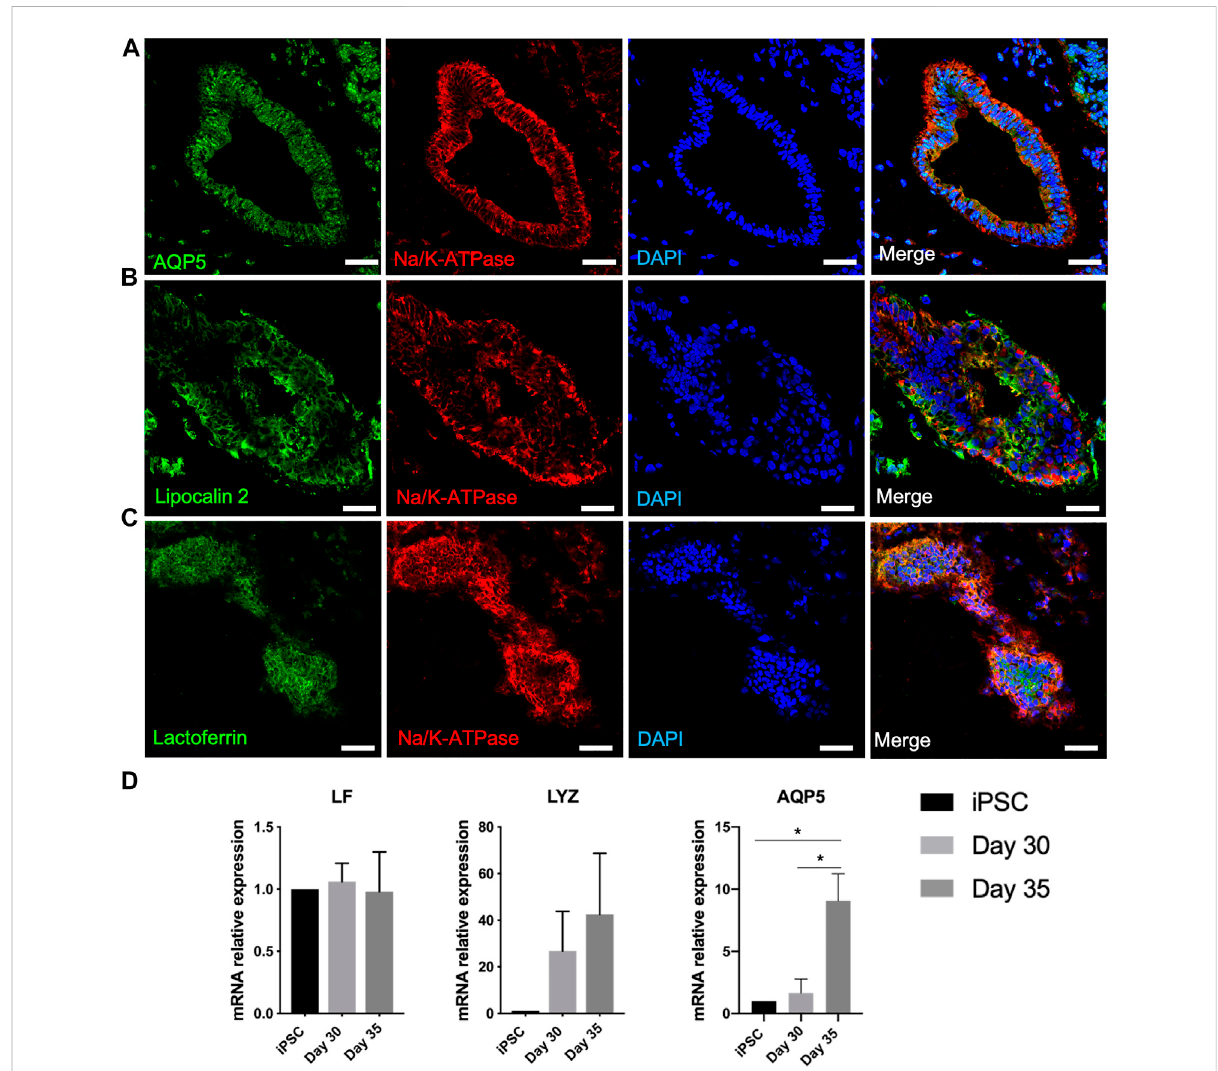
FIGURE 5 Expression of lacrimal gland maturity markers in the protein and mRNA level on day 40 of differentiation con fi rms maturation of lacrimal gland structures (A – C) Acinar cells (Figures are representative of three independent differentiation experiments, scale bar: 40 µm) (D) Expression of markers related to secretory function of lacrimal gland organoids (One-Way ANOVA. Error bars represent standard error of mean. * p ≤ .05, n = 3 biological replicates).